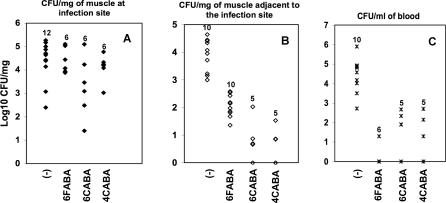
The AA Analogs Restrict Systemic Bacterial Proliferation, but Not Local Proliferation at the Infection SitePA14-infected mice were left untreated (controls) or injected 6 h post-B+I with 6FABA, 6CABA, or 4CABA. The animals were subsequently sacrificed at 22 h post-B+I, and bacteria CFU/mg were determined for (A) muscle tissue that directly underlies the infection site; (B) muscle tissue adjacent to the infection site; and (C) blood. Numbers above dots correspond to the number of mice for each condition. The statistical significance of the CFU/mg differences between the treated and untreated control mice were determined using a Wilcoxon rank sum test. p-Values for the difference in adjacent muscle in response to 6FABA, 6CABA, and 4CABA treatment versus no treatment were 0.00001, 0.00066, and 0.00267, respectively; p-values for the difference in blood with 6FABA, 6CABA, and 4CABA, treatment versus no treatment were 0.00147, 0.00331, and 0.00331, respectively.